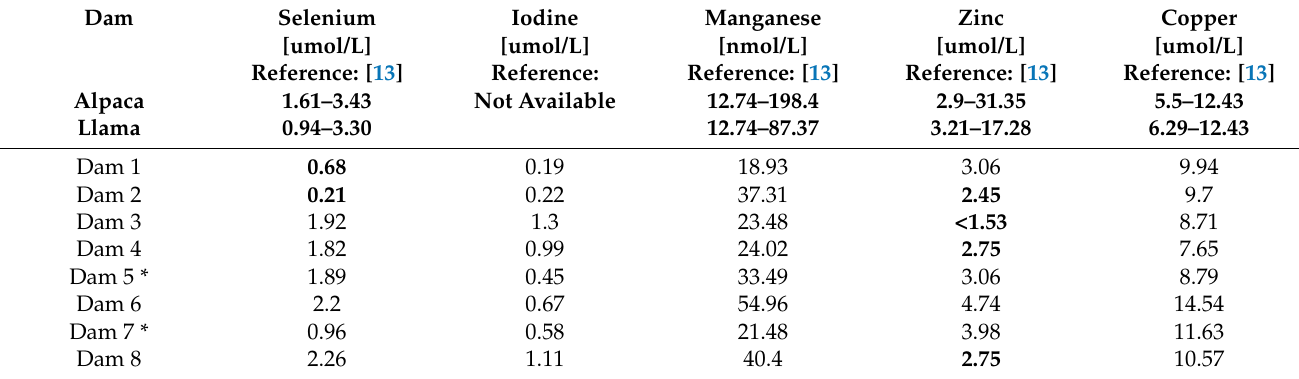
Table 3. Trace mineral status of 8 dams in 7 Swiss South American camelid